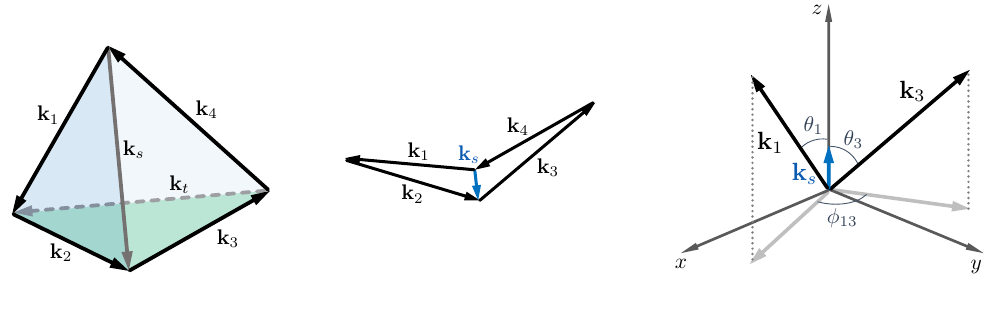
Figure 2 . The momentum configuration of a 4-point function. Left: the six independent momentum variables; middle: the squeezed limit; right: the angles used in the